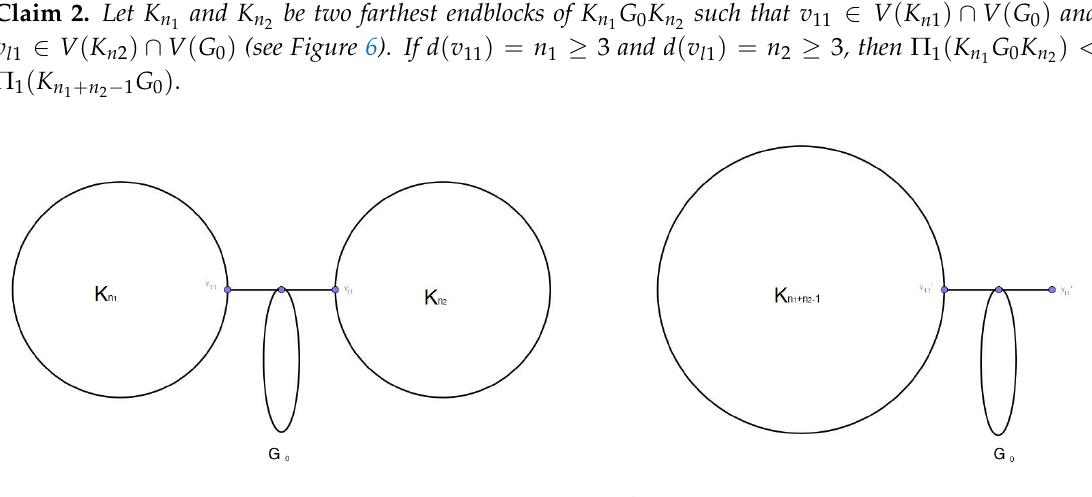
Figure 6. G and G (cid:48)